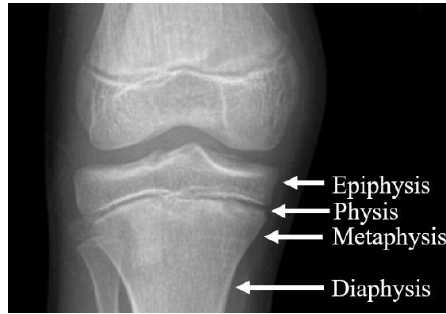
Figure 1. Parts of the growing bone (tibia).